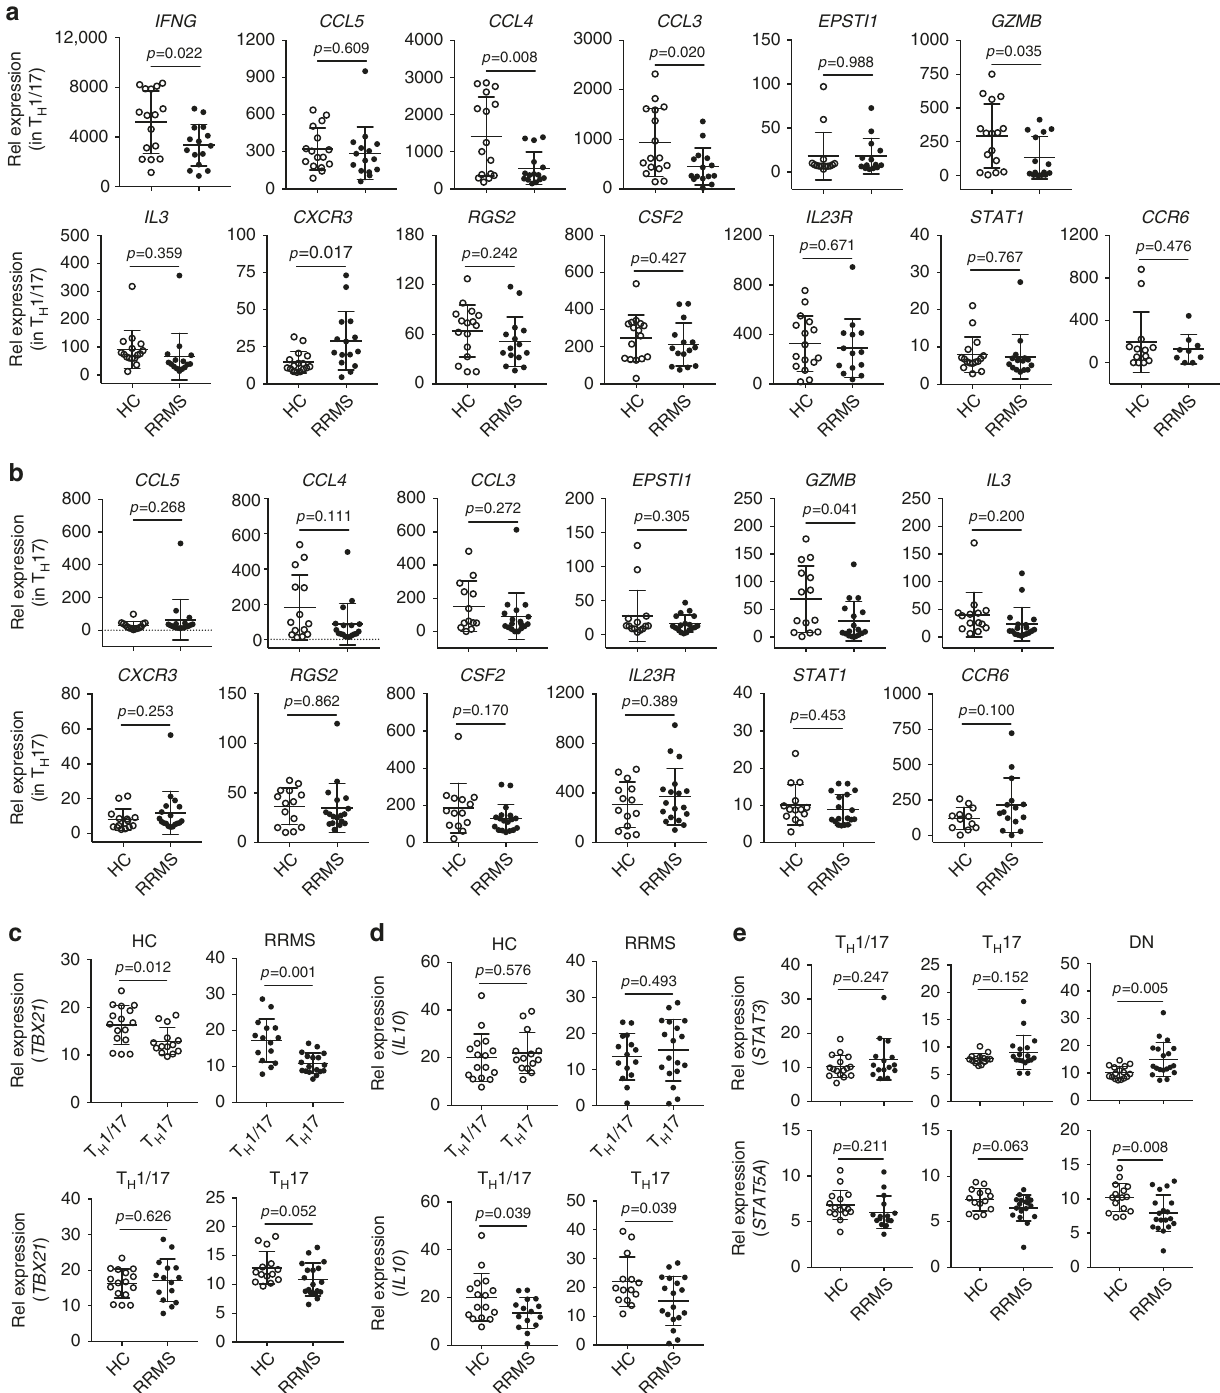
’ s t test p -values H 1/17, T H 17, and DN cells. Welch